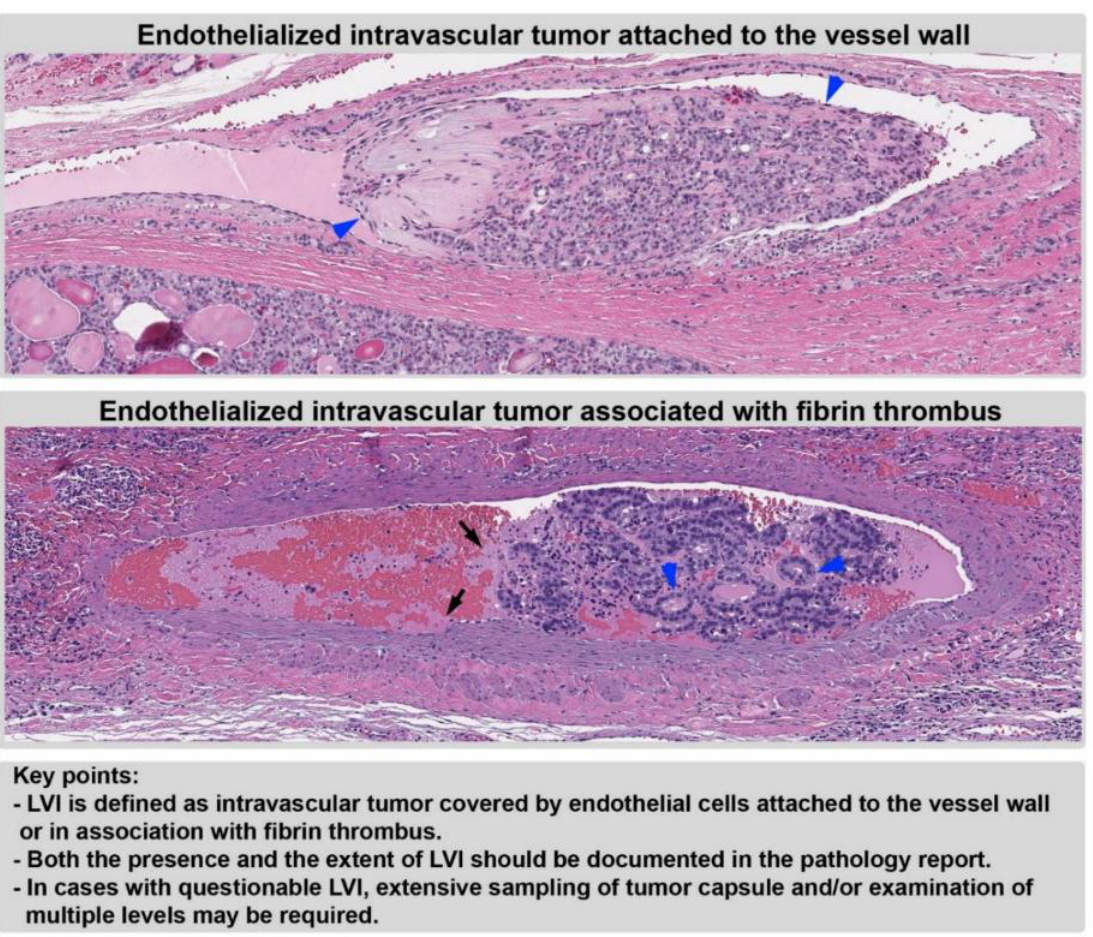
Figure 3. Lymphovascular invasion (LVI). LVI is defined as an intravascular tumor attached to the vessel wall or associated with fibrin thrombi. Blue arrowheads: endothelial cells. Black arrows: fibrin thrombus. Magnification: 200 ×